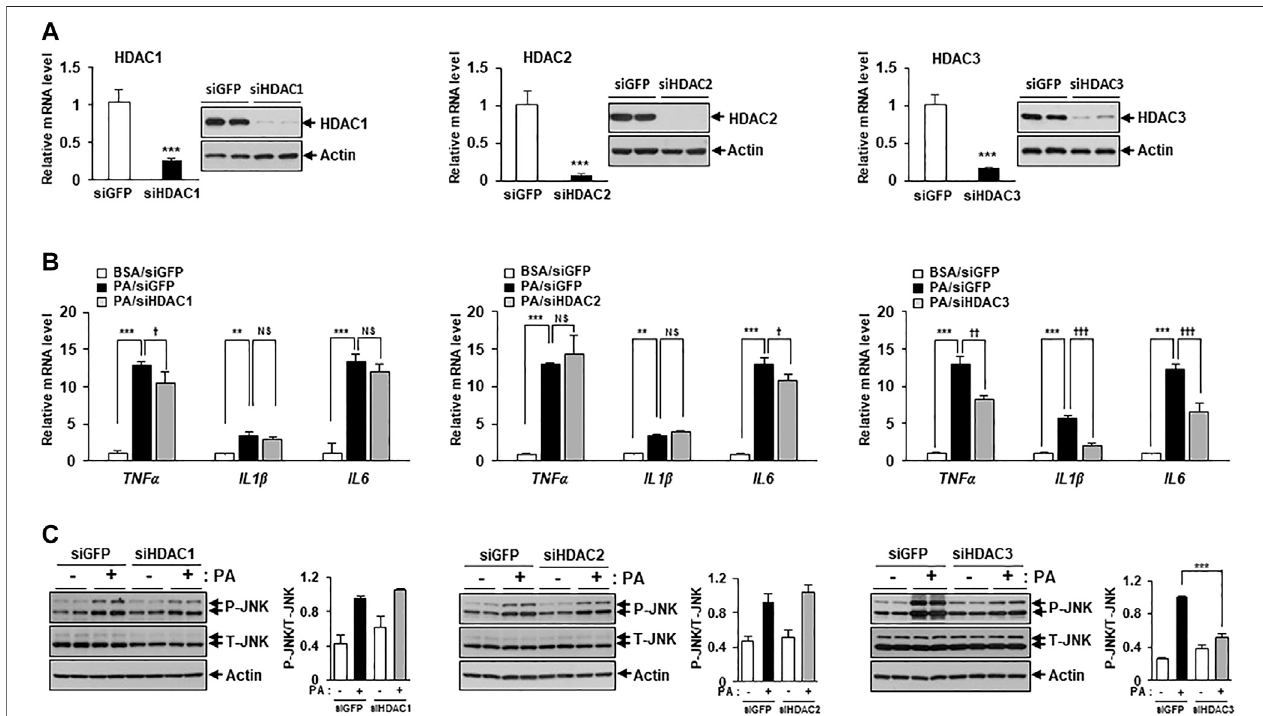
FIGURE 4 | HDAC3 knockdown improved PA-induced in fl ammation. (A) C2C12 myotubes were transfected with HDAC1, HDAC2, HDAC3, or GFP (control) siRNAs.Afterincubationindifferentiationmediafor48h,knockdownofHDAC1,HDAC2orHDAC3wasdeterminedbyreal-timePCRandWesternblot.*** p < 0.001vs. GFP-transfected cells. Transfected C2C12 myotubes were treated with 300 μ M PA for 12 h. The induction of in fl ammatory genes (TNF- α , IL-1 β , and IL-6) was determined by real-time PCR (B) and stress/in fl ammatory signal activation was determined by measuring the levels of p-JNK by Western blot (C) . *** p < 0.001 vs. GFP-transfected cells, †† p < 0.01; ††† p < 0.001 vs. GFP-transfected and PA-treated